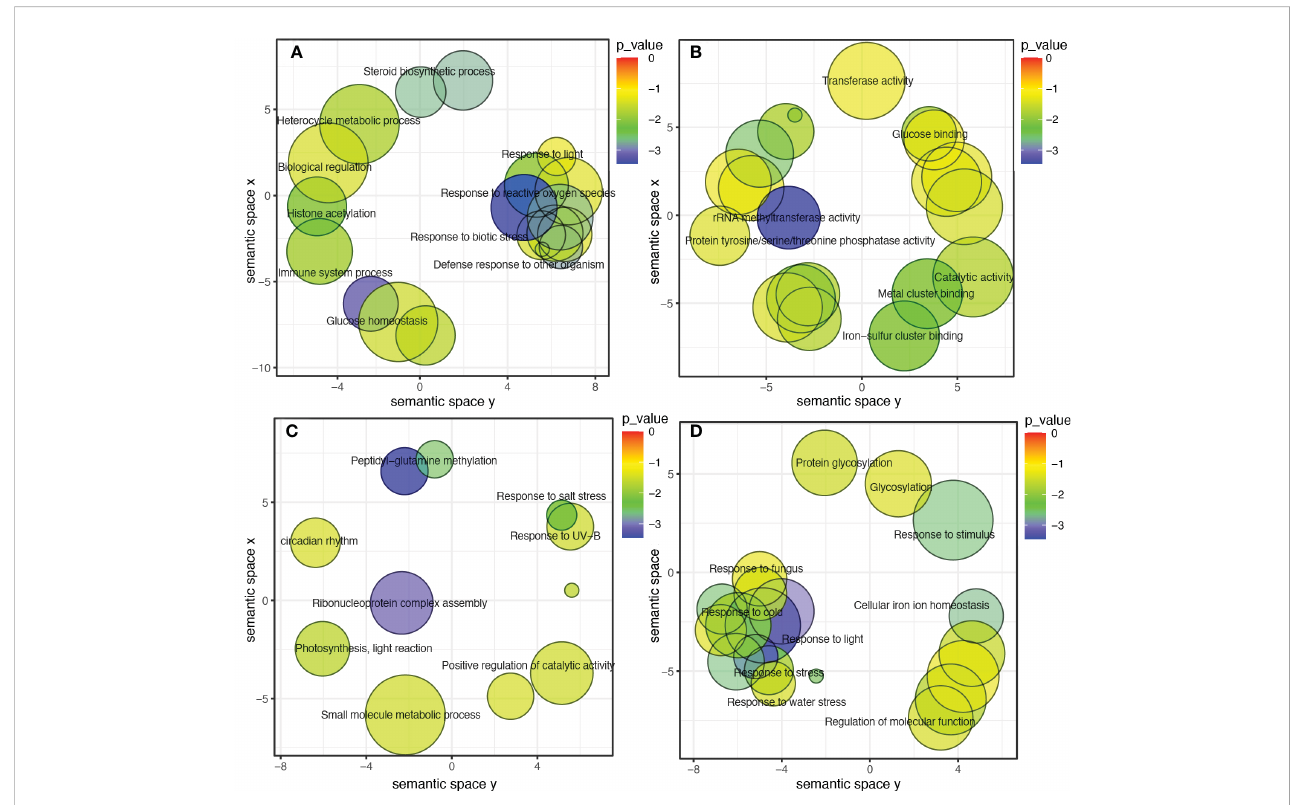
FIGURE 6 (A) GO categories for biological process, brown module. (B) GO categories for molecular function, brown module. (C) Categories for biological process, green module. (D) Categories for biological process, magenta